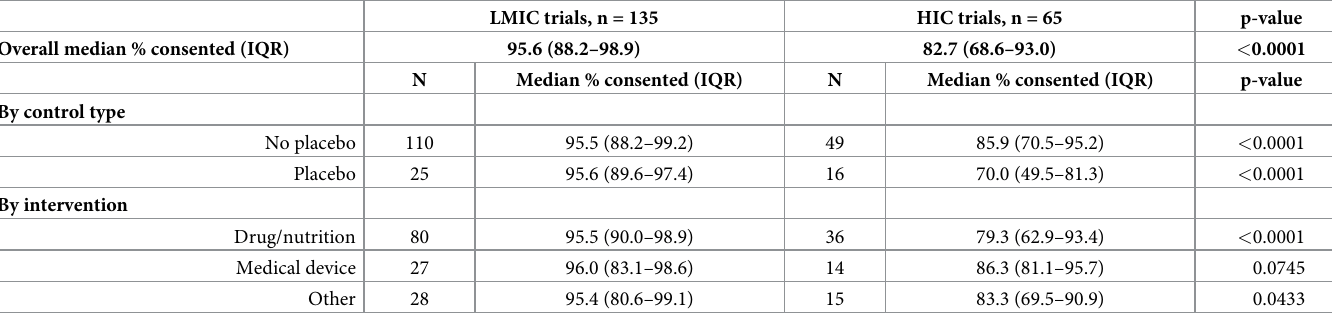
Table 2. Consent rates in LMIC versus HIC neonatal randomized controlled